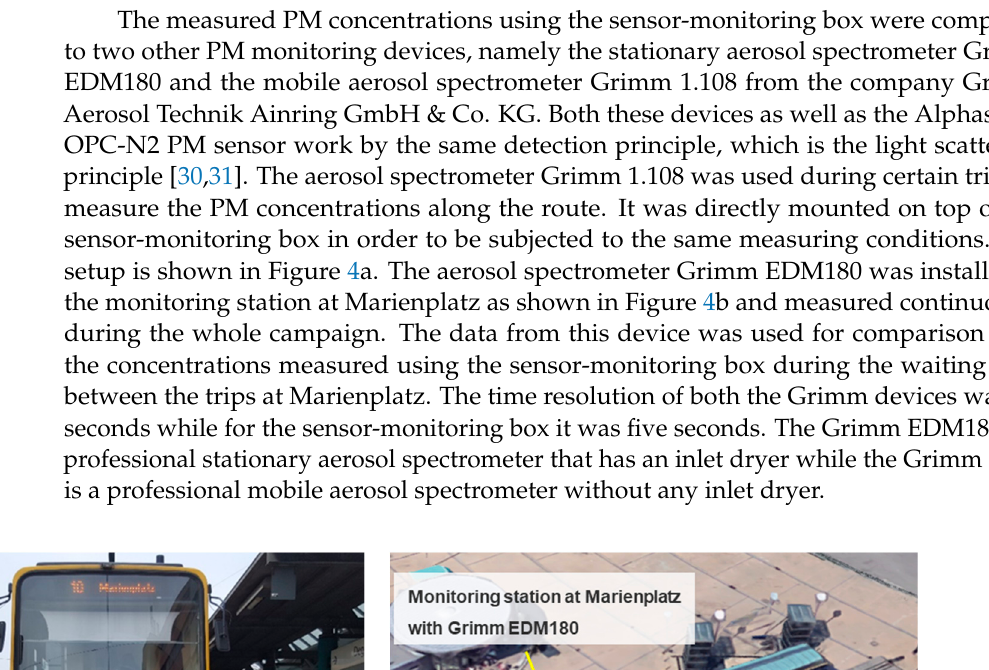
Figure 3. ( a ) Custom made box-hanger diagram, ( b ) Position of the sensor-monitoring box on the bicycle cart.